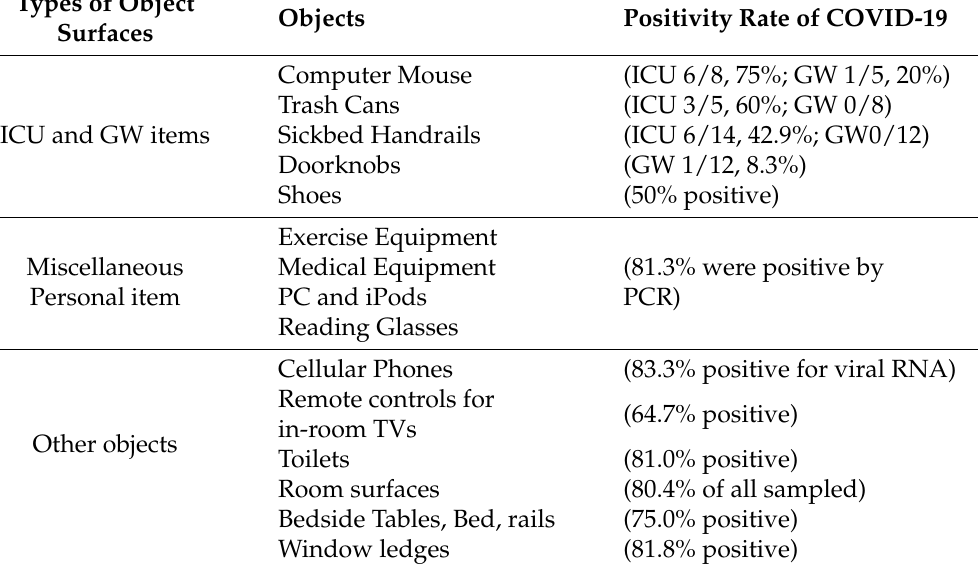
Table 1. Objects and Surfaces found positive of COVID-19